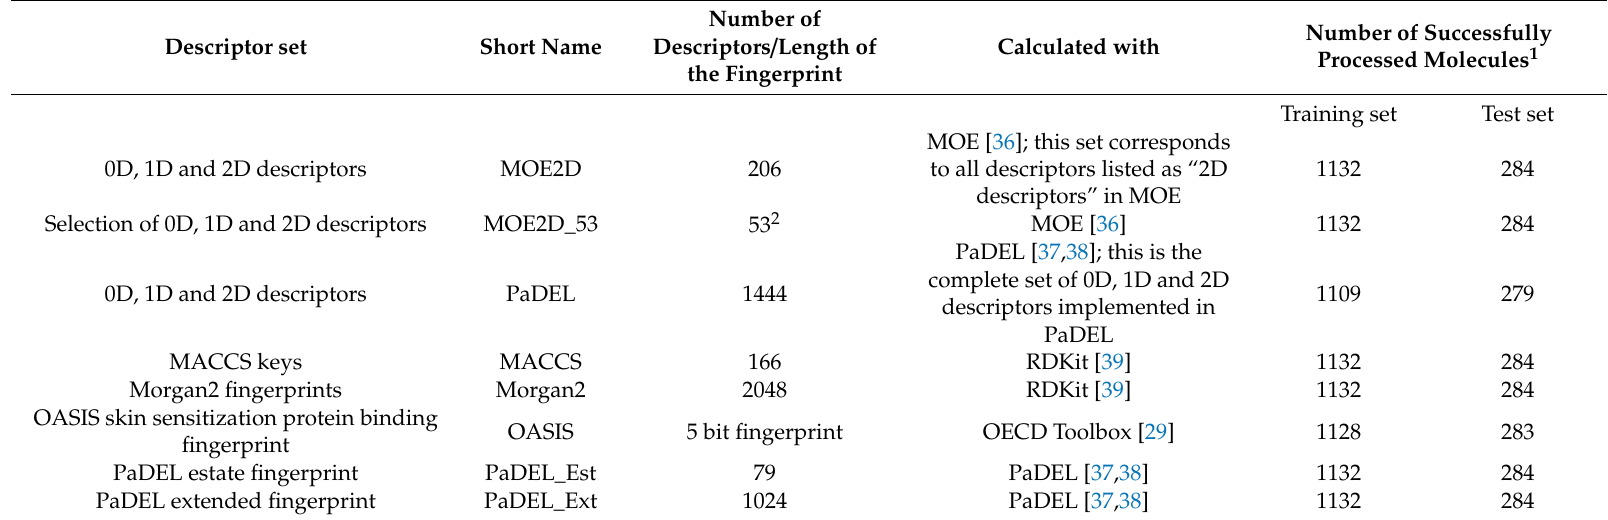
Table 3. Overview of descriptor sets evaluated in this